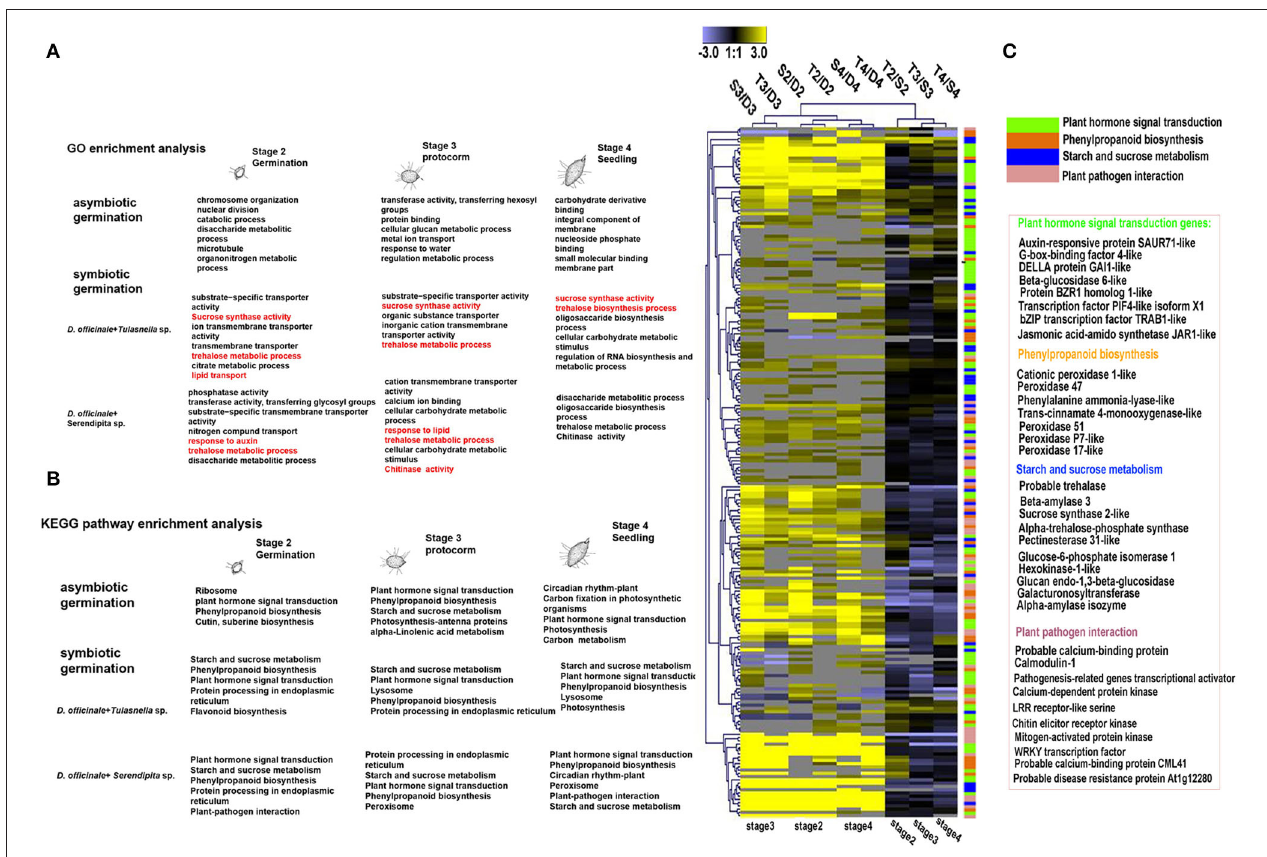
FIGURE 4 | KEGG and GO enrichment analysis of differentially expressed plant genes (DEGs) during germination of D. officinale seeds with two mycorrhizal fungi. (A) GO enrichment analysis; red color indicated that typical Go functional enrichment for these genes involved in symbiotic germination compared to asymbiotic germination. (B) KEGG pathway enrichment analysis showed that the significant enrichment pathway exists as overlaps between symbiotic and asymbiotic germination. It means these pathways could be most important during seed development. And the symbiotic germination with two fungal species have similar metabolic pathway but also display difference e.g., lysosome in Tulasnella sp.- D.officinale and peroxisome in Serendipita sp .- D.officinale ; (C) heatmap showing the expression profile of genes in the significantly enriched four metabolic pathways during symbiotic germination of D.officinale (such as plant hormone signal transduction, phenylpropanoid biosynthesis, starch, and sucrose metabolism and plant-pathogen interaction); expression value was calculated based on Log2 Fold change. Significant expression changes were labeled in colors: blue represents down regulated and yellow represents up regulated. The functional annotation of representative genes in each enriched pathway was recorded in heatmap